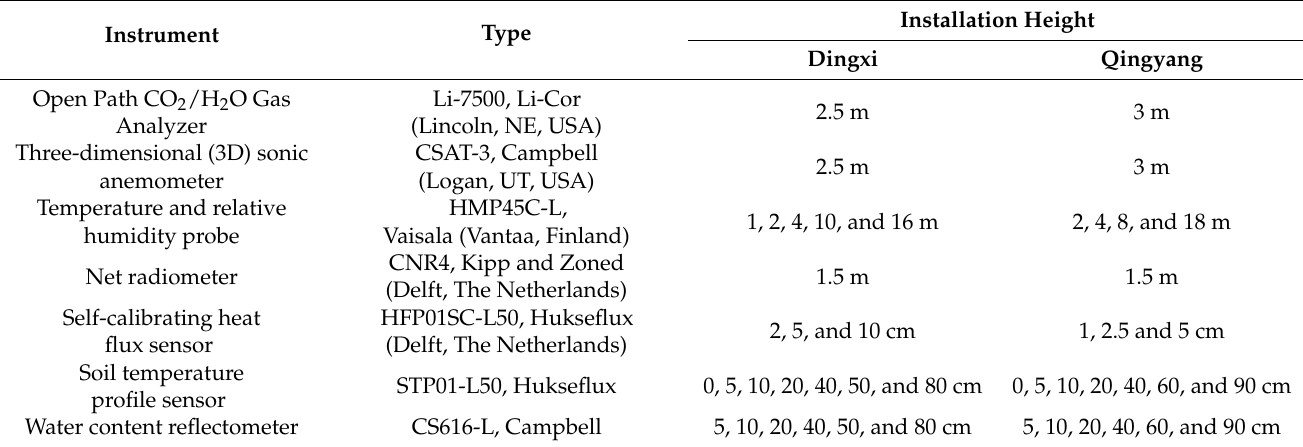
Table 1. Measurement instruments and installation